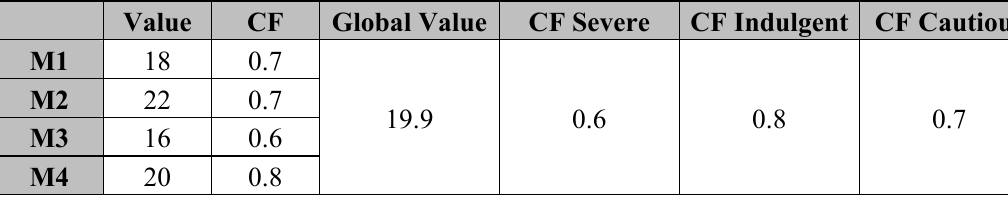
Table 1. Example of the data